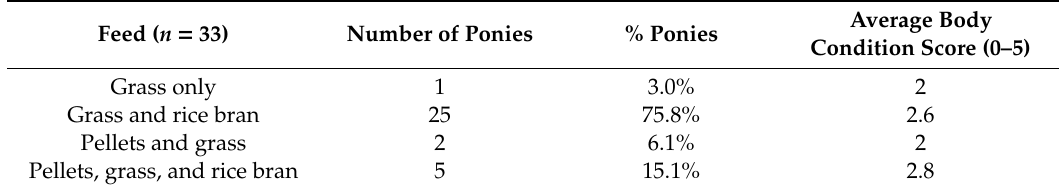
Table 5. Gili pony